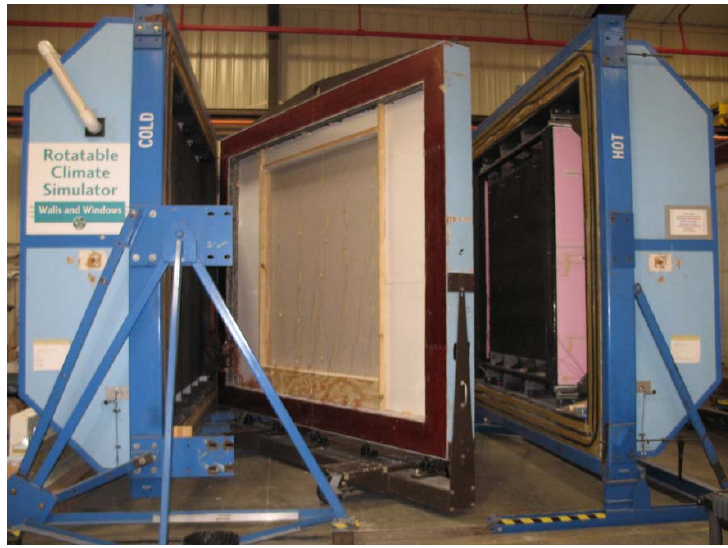
Figure 4. Guarded hot box for testing large ‐ scale composites.